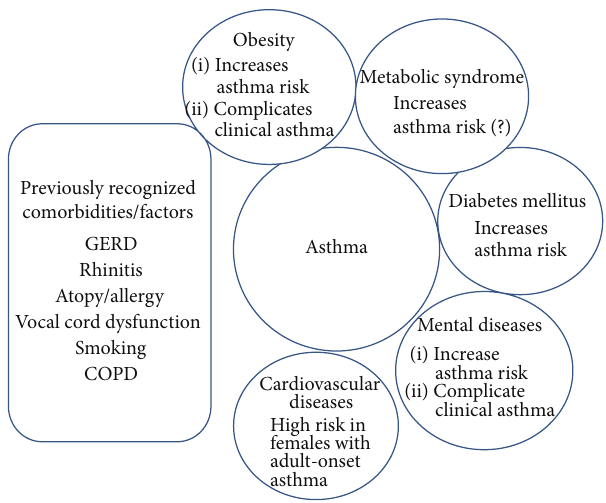
Figure 1: Emerging comorbidities in